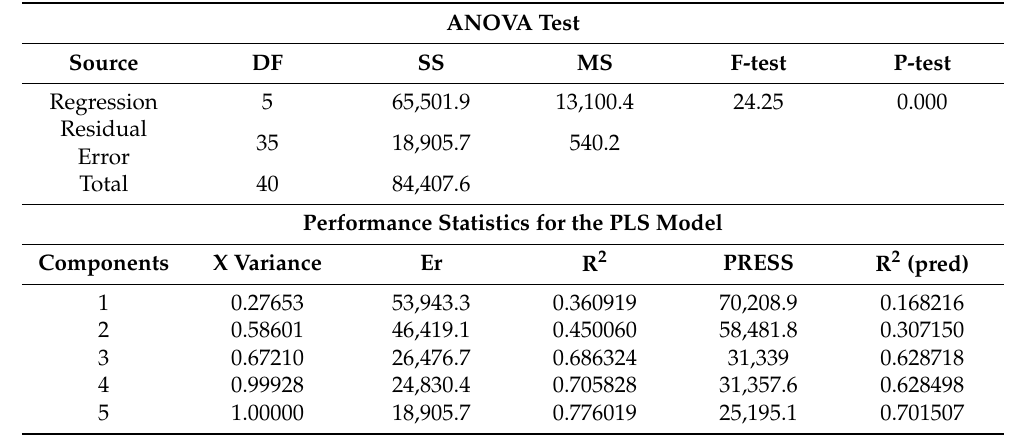
Figure 3. PLS response plot (5 components)—q u max . Table 5. Summary of the performance statistics for the PLS model—q u max .